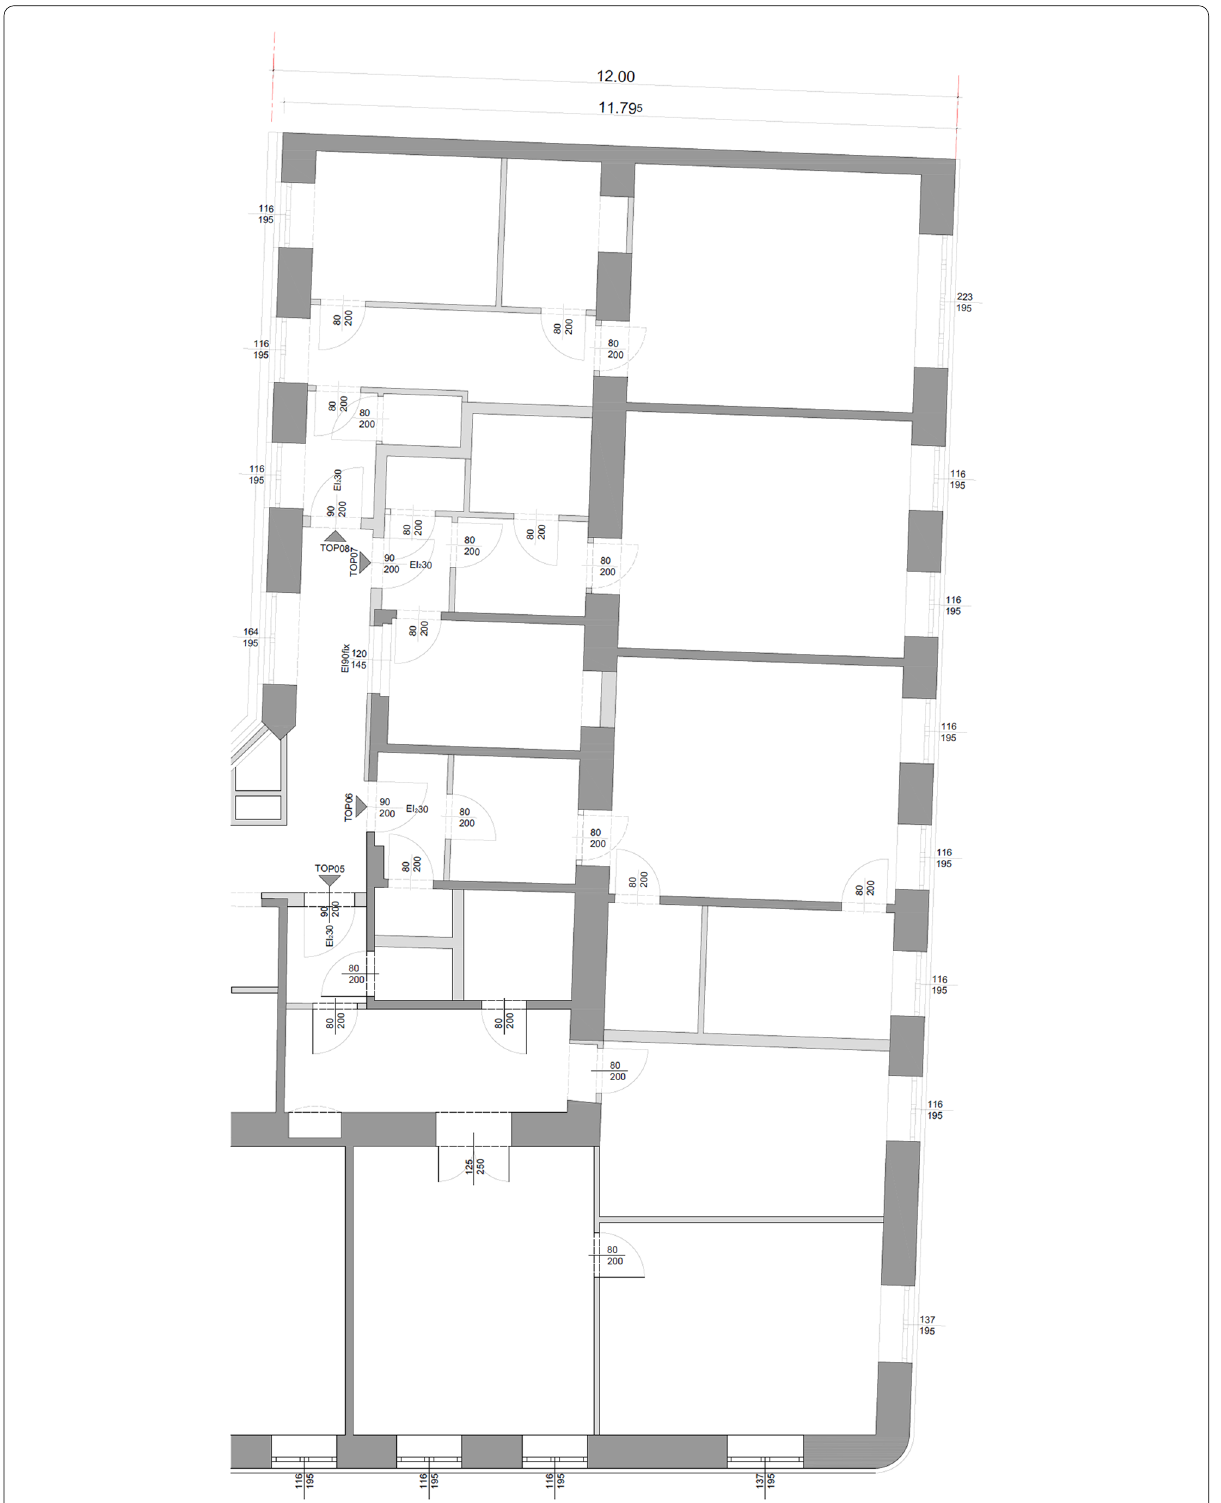
Fig. 8 Floor plan of all floors of the three-storey apartment building used within the model calculations to assess which building components of the respective building types can be neglected (Natanian et al.